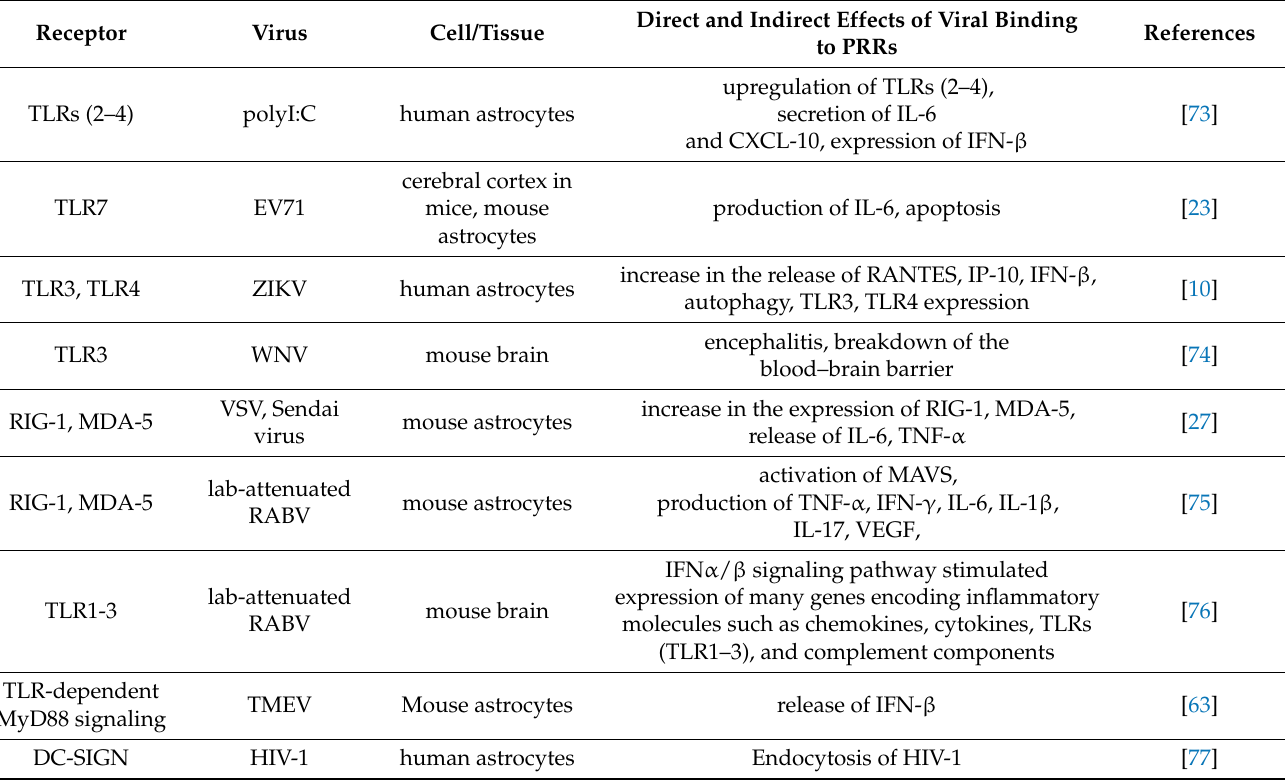
Table 1. Interactions between pattern recognition receptors (PRRs) and viruses in astrocytes.